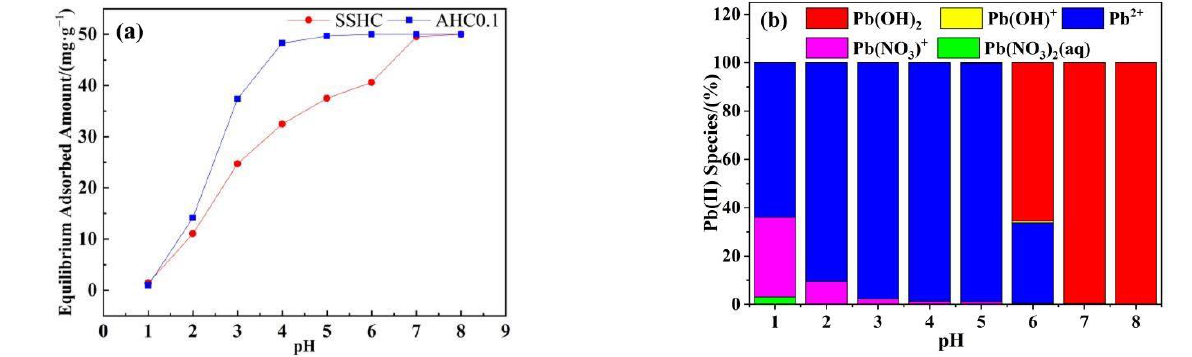
Figure 8. Effects of initial pH on Pb( Ⅱ ) adsorption ( a ) and Pb species under different pH ( b ).